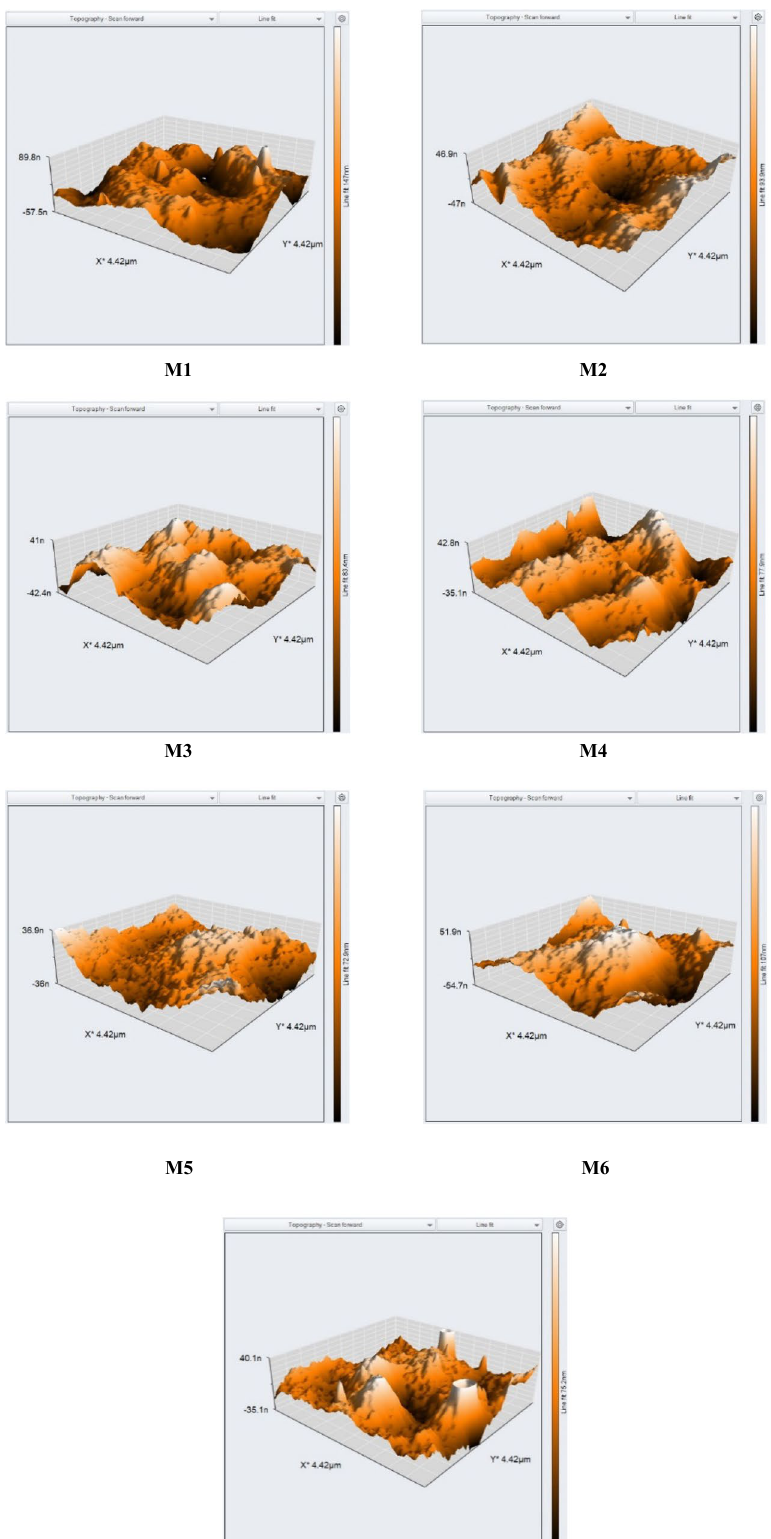
Fig. 4 AFM images of